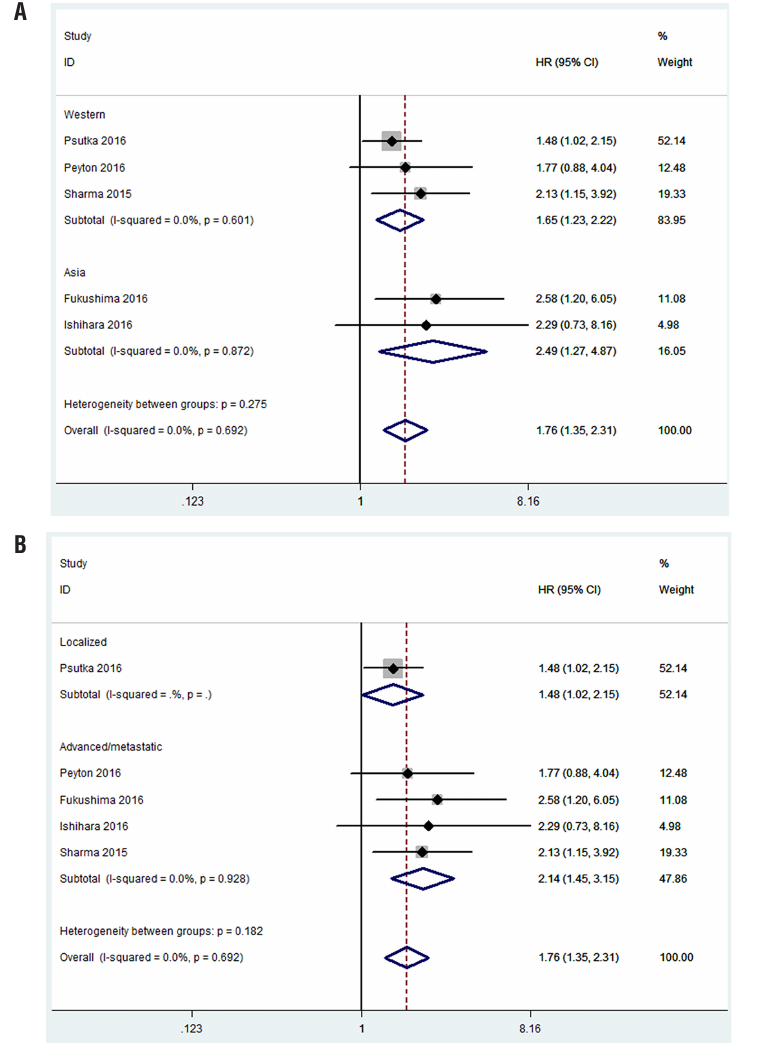
Figure 6 - Subgroup analyses of OS: A: stratified by regions; B: stratified by